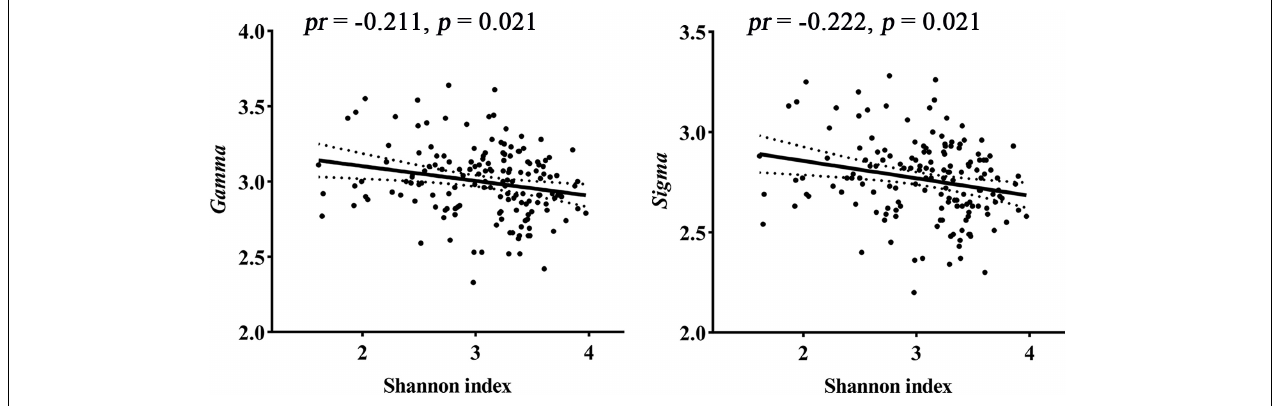
FIGURE 2 | Correlations between gut microbial diversity and small-worldness parameters of SC. pr , partial correlation coefficient; SC, structural